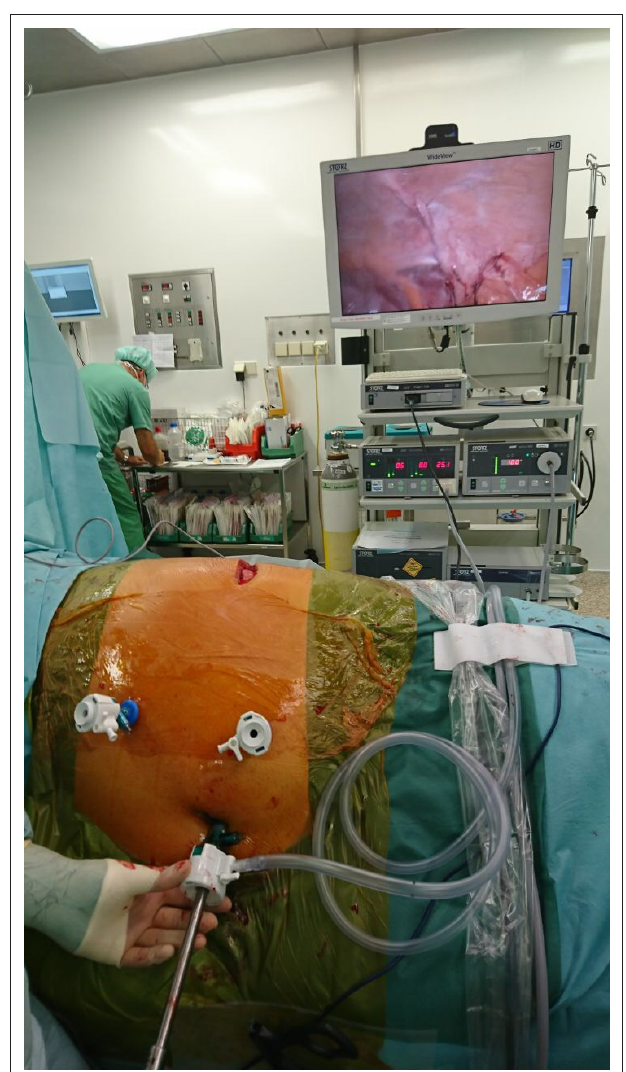
FIgure 1 | Operative setting. Trocars for instruments are inserted cranially and caudally in an appropriate angle to the hernia (note the skin incision on the left flank); whereas the optic trocar is placed